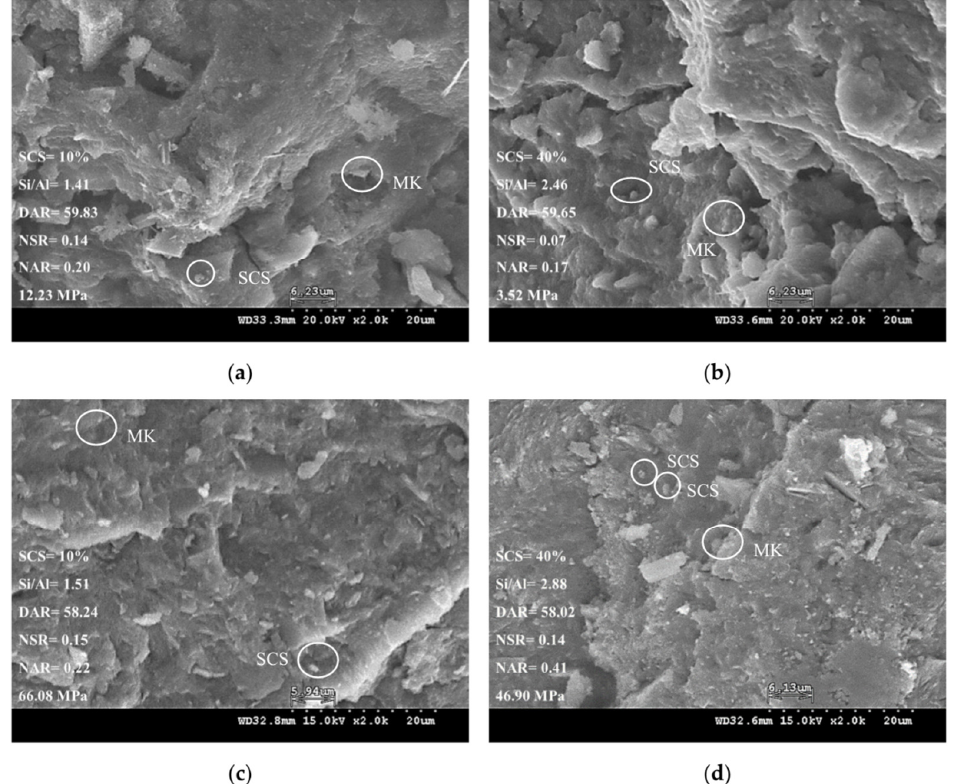
Figure 4. Micrographs of SCSGPs with different mix design parameters and compressive strength (SCS = 10% and 40%, the NSR = 0.07–0.15, the NAR = 0.17–0.41, the DAR = 58.02–59.83, and compressive strength (MPa) = 3.52–66.08), i.e., ( a ) SCS = 10% and the Si/Al = 1.41, ( b ) SCS = 40% and the Si/Al = 2.46, ( c ) SCS = 10% and the Si/Al = 1.51, ( d ) SCS = 40% and the Si/Al = 2.88. The microstructures of the SCSGPs varied slightly when the DAR values were